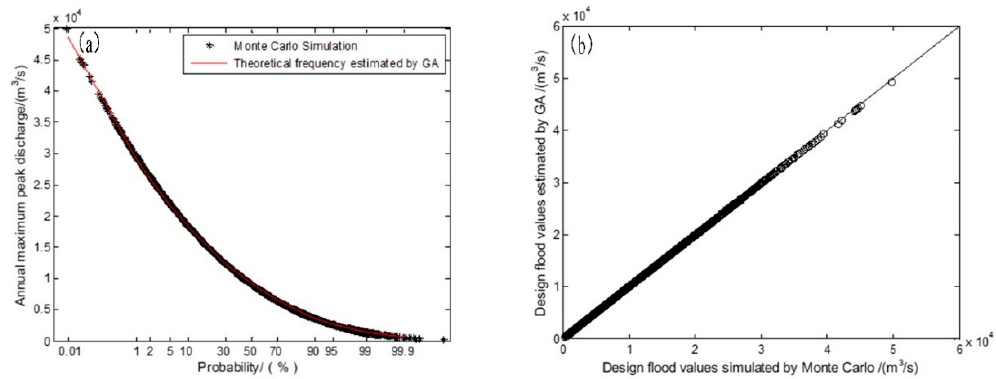
Figure 4. Variation between the design flood value of annual maximum peak discharge series (AMPDS) simulated by Monte Carlo and estimated by genetic algorithm (GA). ( a ) Design flood values of AMPDS simulated by Monte Carlo and estimated by GA at different return periods; and ( b ) Quantile-Quantile plots between design flood values of AMPDS simulated by Monte Carlo and estimated by GA.